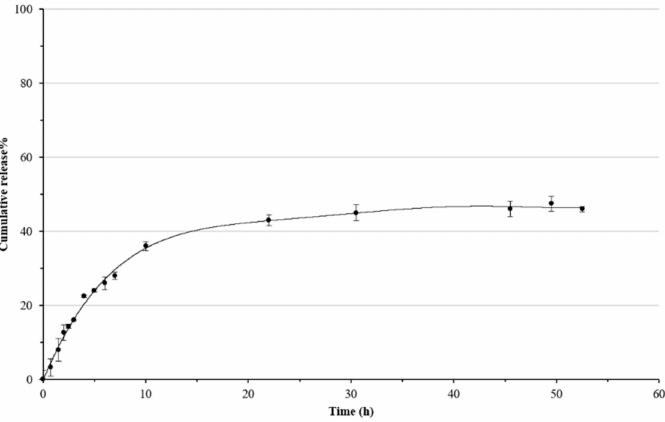
Figure 4. Cumulative release of capsaicin from Carbopol-based formulation.